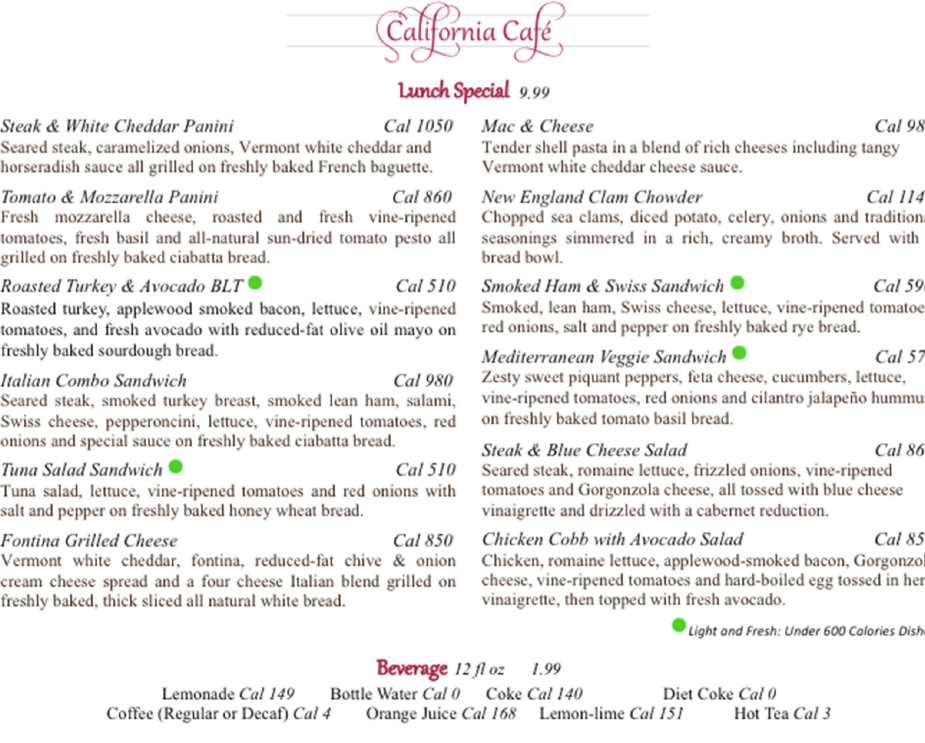
Figure A9. Urban Mexican Control Menu.